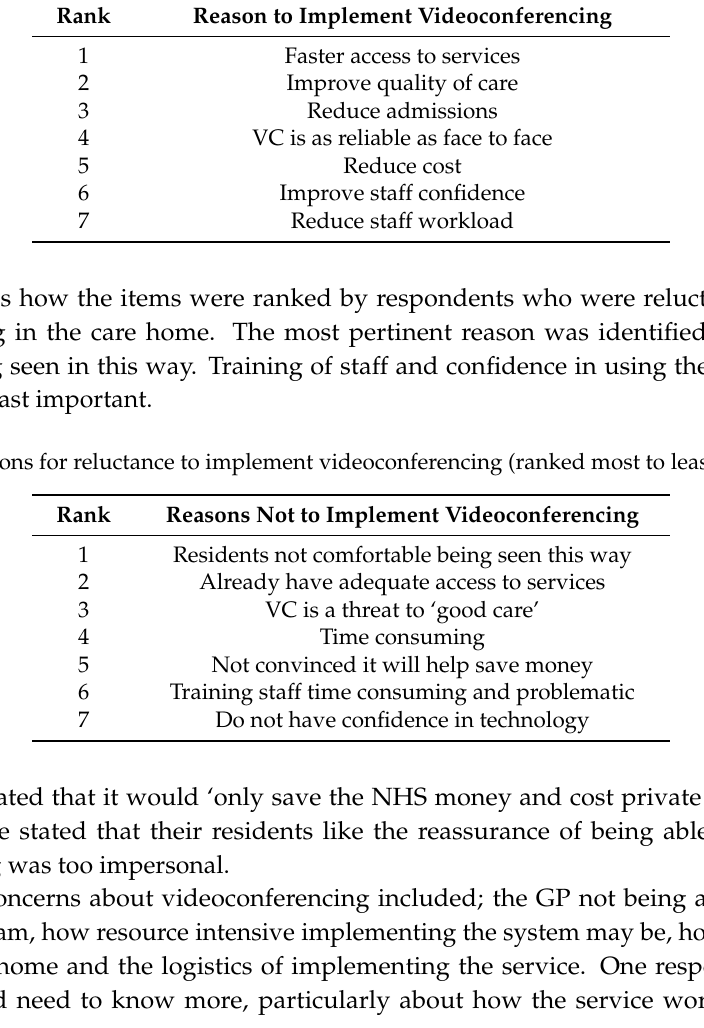
Table 5. Pertinence of reasons to implement videoconferencing (ranked most to least important). Rank Reason to Implement Videoconferencing 1 Faster access to services